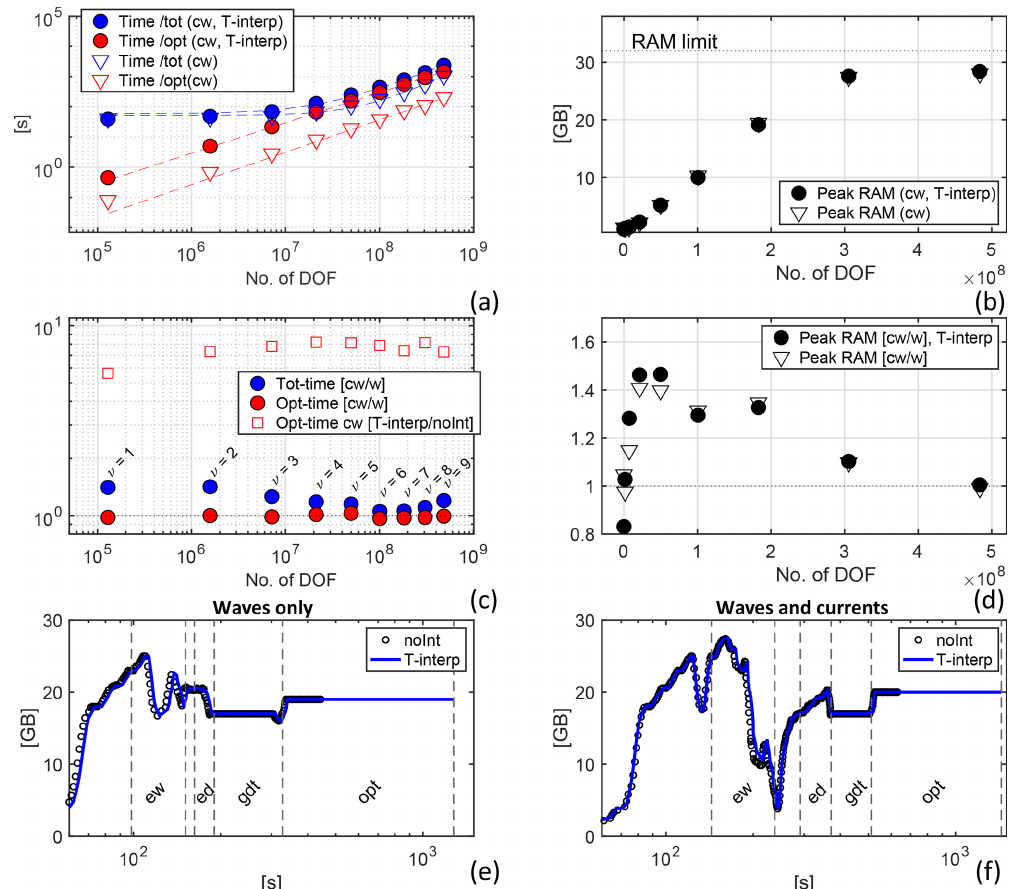
Figure 3. (a) CPU time for the total VISIR job (blue markers) and for just the computation of the time-dependent shortest path (red markers). Only the cw case is considered. Dashed lines are fits of the model in Table 3. (b) Peak RAM allocation during the computing jobs of (a) , with a reference line at the total installed RAM. (c) Ratio of CPU times between the cw and w cases and (just for optimal path) with and without time interpolation (T-interp). (d) Ratio of peak RAM allocation of the cw- to w-type jobs. For panels (a) , (b) , and (d) , both cases are with (filled markers) and without (empty markers) time interpolation. The DOF of the time-dependent shortest path problems is displayed on the horizontal axis. (e, f) Time series of RAM memory allocation during VISIR execution for w- and cw-type jobs, respectively. Black circles (blue lines) refer to runs without (with) time interpolation of edge weights. Vertical dashed lines separate the main phases of the processing. Both panels refer to the ν = 8 case of (a–d) . The processing phase labels are as follows: ew (computation of edge-averaged fields), ed (edge delays), gdt (geodetic track), and opt (optimal track).